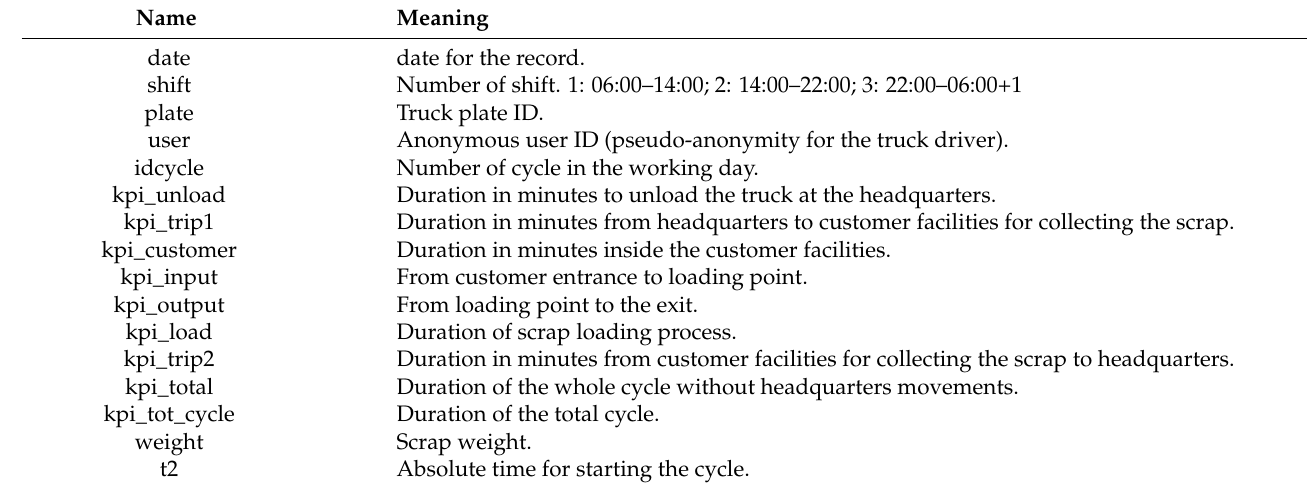
Table 1. Monitored KPIs Case Study